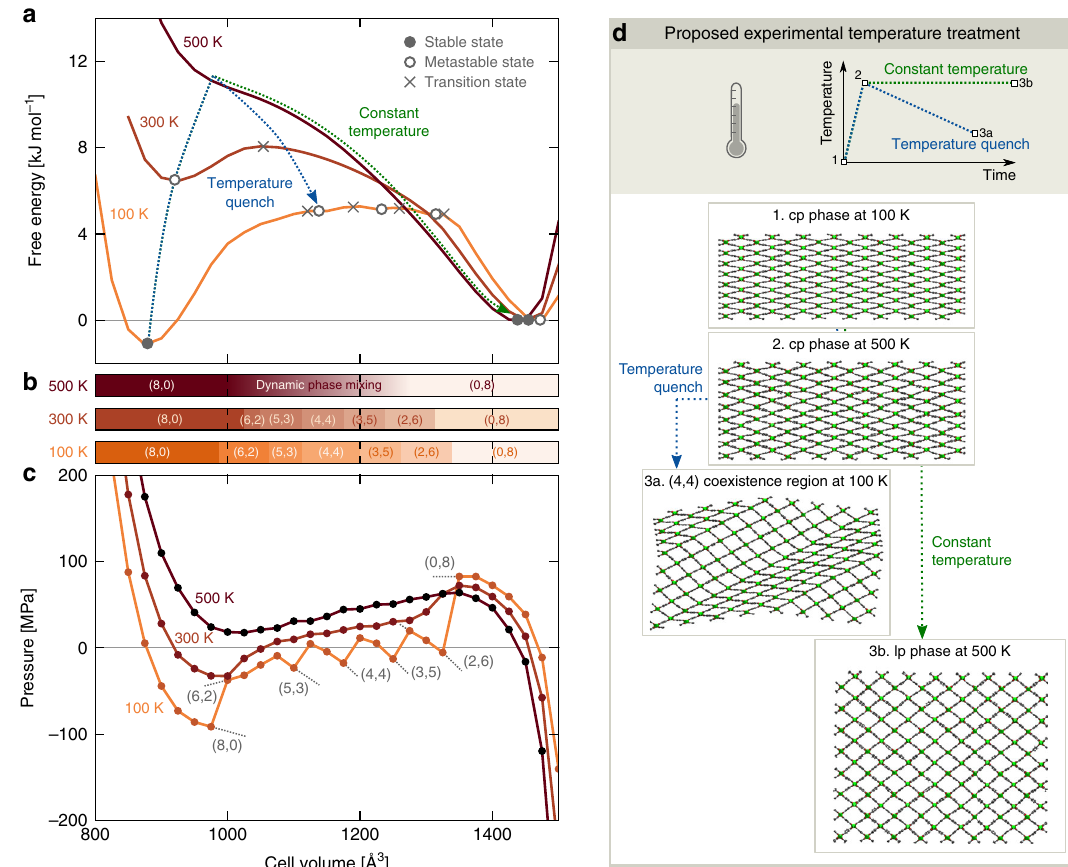
Fig. 5 Using temperature as a stimulus to access the metastable cp/lp coexistence regions in MIL-53(Al)-F. a Free energy and c pressure equations of state at 100 K, 300 K, and 500 K, with b indication of the metastable ( n , n ) phase coexistence regions as a function of the volume for an 8 × 2 × 8 mesocell of cp lp MIL-53(Al)-F. The different (meta)stable states and transition states are indicated on the free energy equations of state with (open) circles and crosses, respectively. d The material ’ s response upon two different temperature treatments is predicted: a constant-temperature treatment (green) and a temperature quenching treatment (blue), demonstrating how the latter leads to a stabilized (4,4) phase